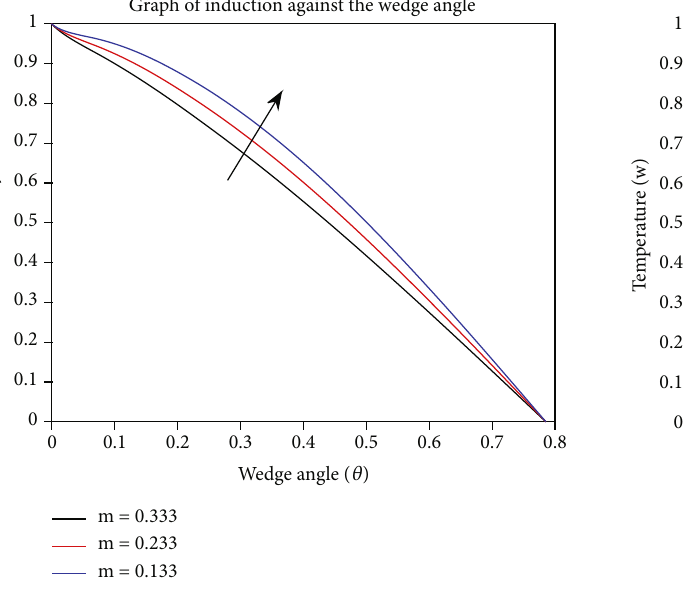
Figure 4: Magnetic induction pro fi les.